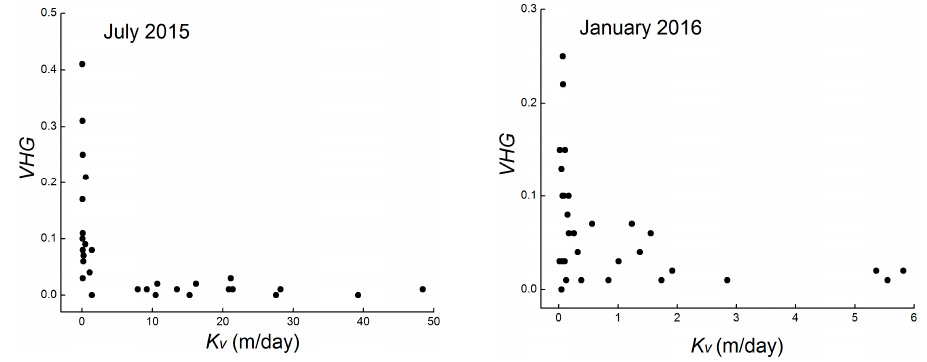
Figure 9. Relationship between K v and VHG during the two test periods.